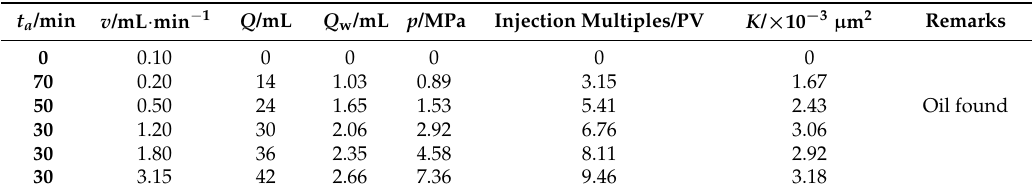
Table 10. Saturated oil experiment results.